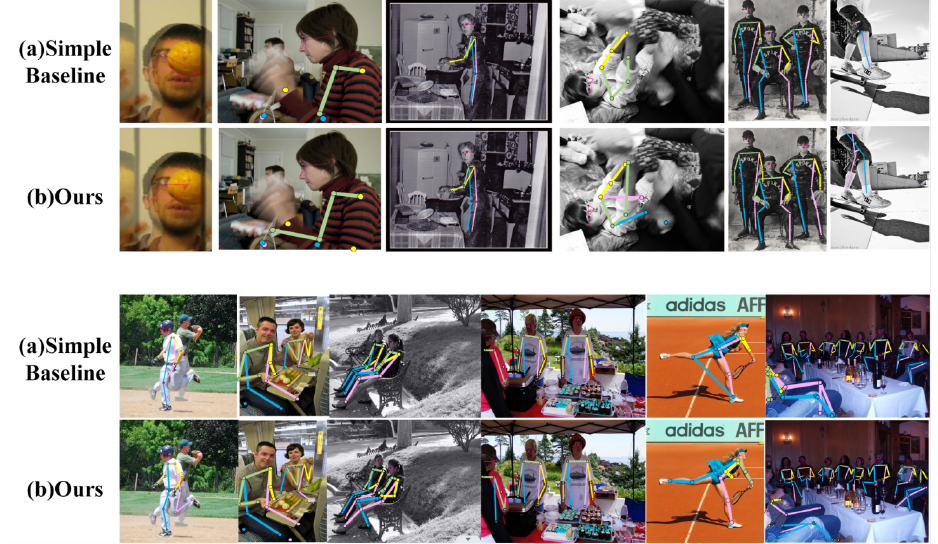
Figure 7. More visual comparison results. As can be seen from the figure, our method can estimate the human posture more accurately when the image is blurred or blocked. In addition, our model performs better in both single-person and multi-person